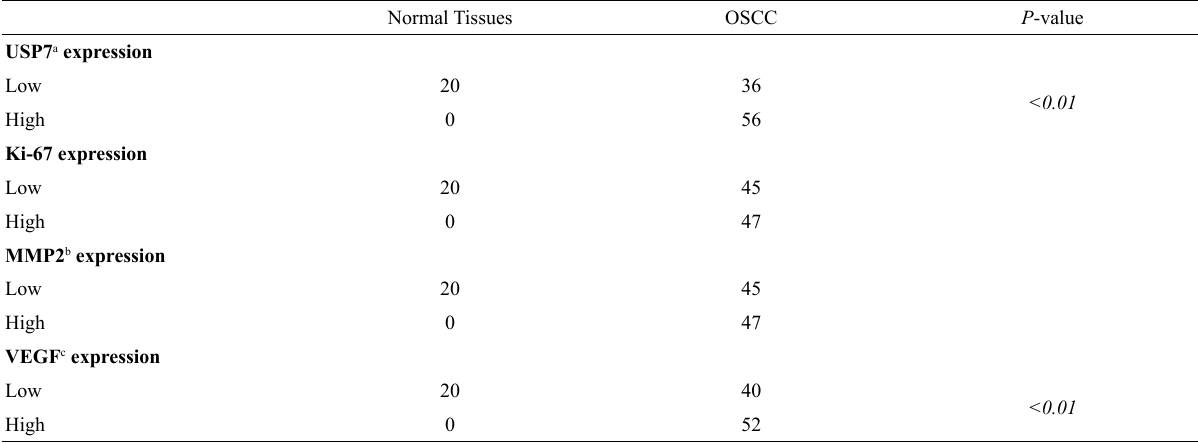
Table 1 – Differential expression analysis of USP7, Ki-67, MMP2 and VEGF in OSCC and normal tissues. Normal Tissues OSCC P -value